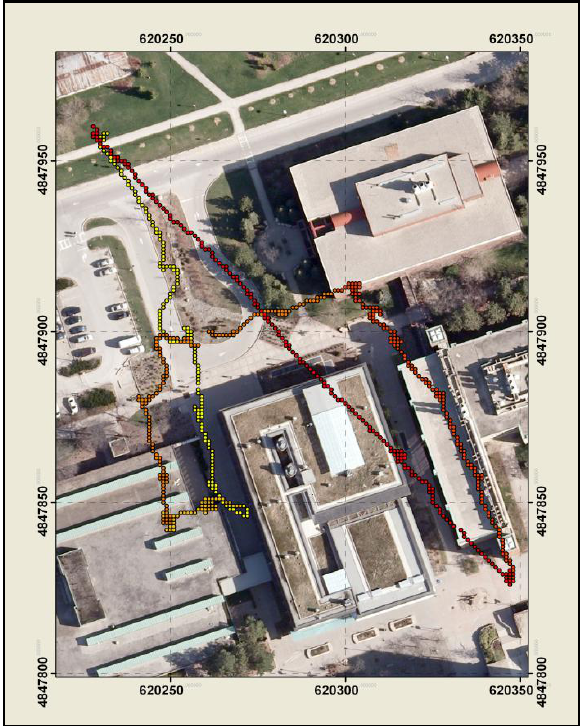
Figure 4. UAS flight path around the Lassonde